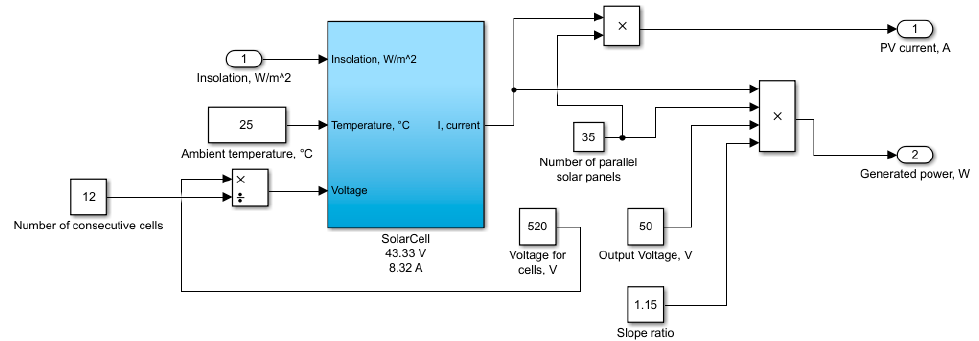
Figure 5. Solar Energy Matlab/Simulink model subsystem.